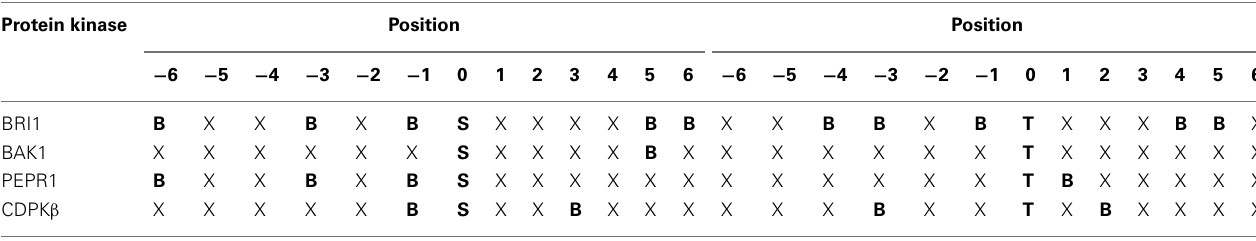
Table 5 | Summary of preference for basic residues (B) surrounding serine and threonine phosphosites in bacterial proteins targeted by recombinant protein kinases expressed in E. coli . Protein kinase